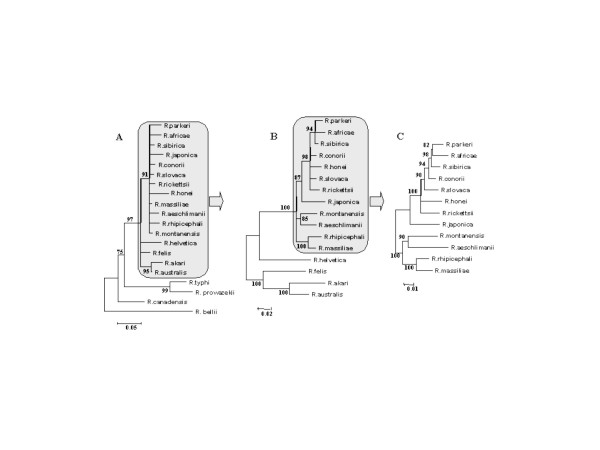
Dendrogram representing phylogenetic relationships between Rickettsia species inferred from comparison of Sca1 amino acid sequences. The Neighbor-Joining phylogenetic tree was inferred with the MEGA software version 2.1. The numbers at the nodes are the proportion of 100 bootstrap resamplings that support the topology shown. The scale bar indicates a 5 % sequence divergence. 1A: phylogeny of all 20 species using an alignment of the autotransporter domain; 1B: phylogeny of spotted fever group rickettsiae inferred from the comparison of full Sca1 sequences; 1C: phylogenetic resolution of members of the R. rickettsii and R. massiliae clusters.